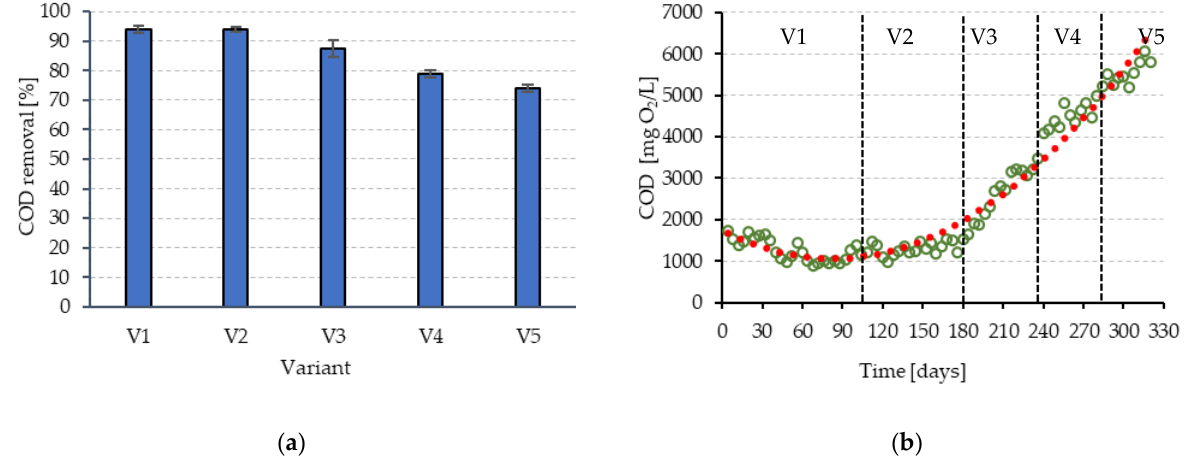
Figure 2. The efficiency of anaerobic dairy treatment in stage 1: ( a ) organic compound removal as COD with a standard deviation in experimental variants V1–V5; ( b ) COD concentration in the effluent during the experimental time (variants V1–V5).